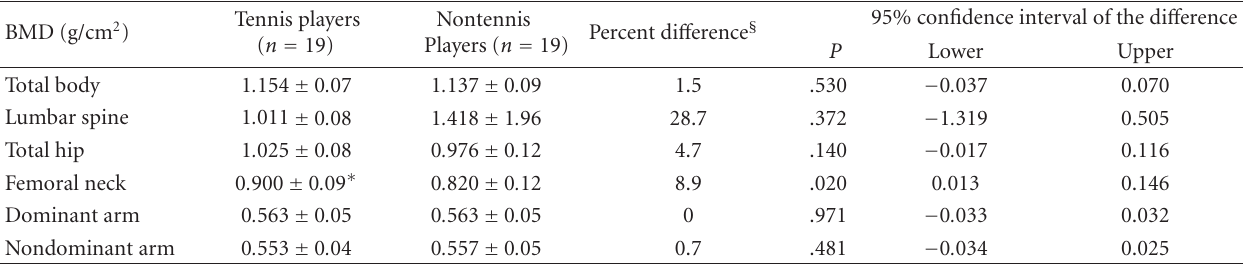
Table 2: Bone mineral density measurements of adolescent tennis players and nontennis players.